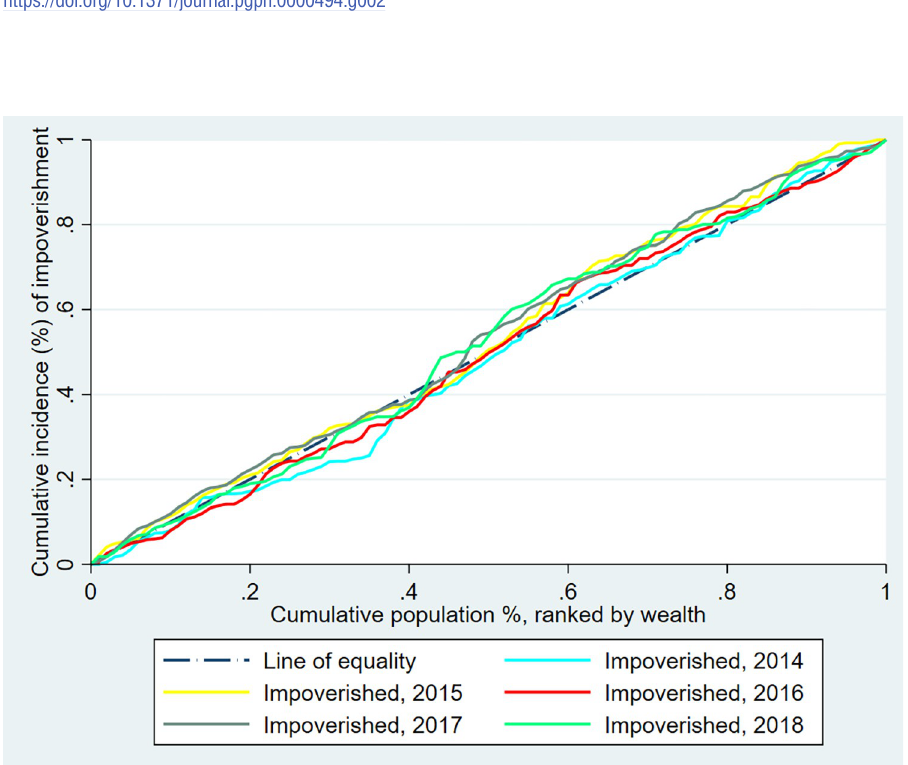
Fig 3. Concentration Curve for impoverishment by year in Armenia– 2014 to 2018 ILCS.